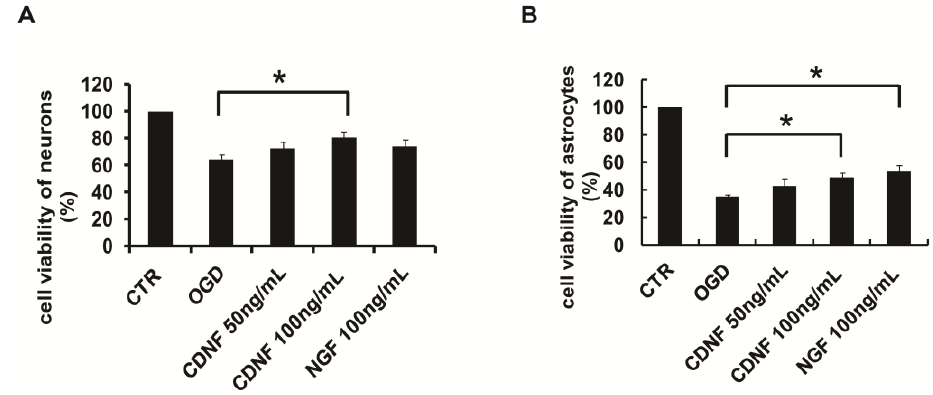
Figure 3. The effects of CDNF on cultured primary neurons and astrocytes during OGD treatment. ( A ) Preincubation of CDNF (100 ng/mL) significantly increased the cell viability of primary neurons that was caused by OGD. ( B ) Preincubation of CDNF (100 ng/mL) significantly increased the cell viability of primary astrocytes that was caused by OGD. NGF (100 ng/mL) was used as a positive control. * p < 0.05 CDNF (100 ng/mL) or NGF (100 ng/mL) versus OGD group tested by one-way Analysis of Variance (ANOVA). Three independent experiments were performed and the reported data represent the mean of the three